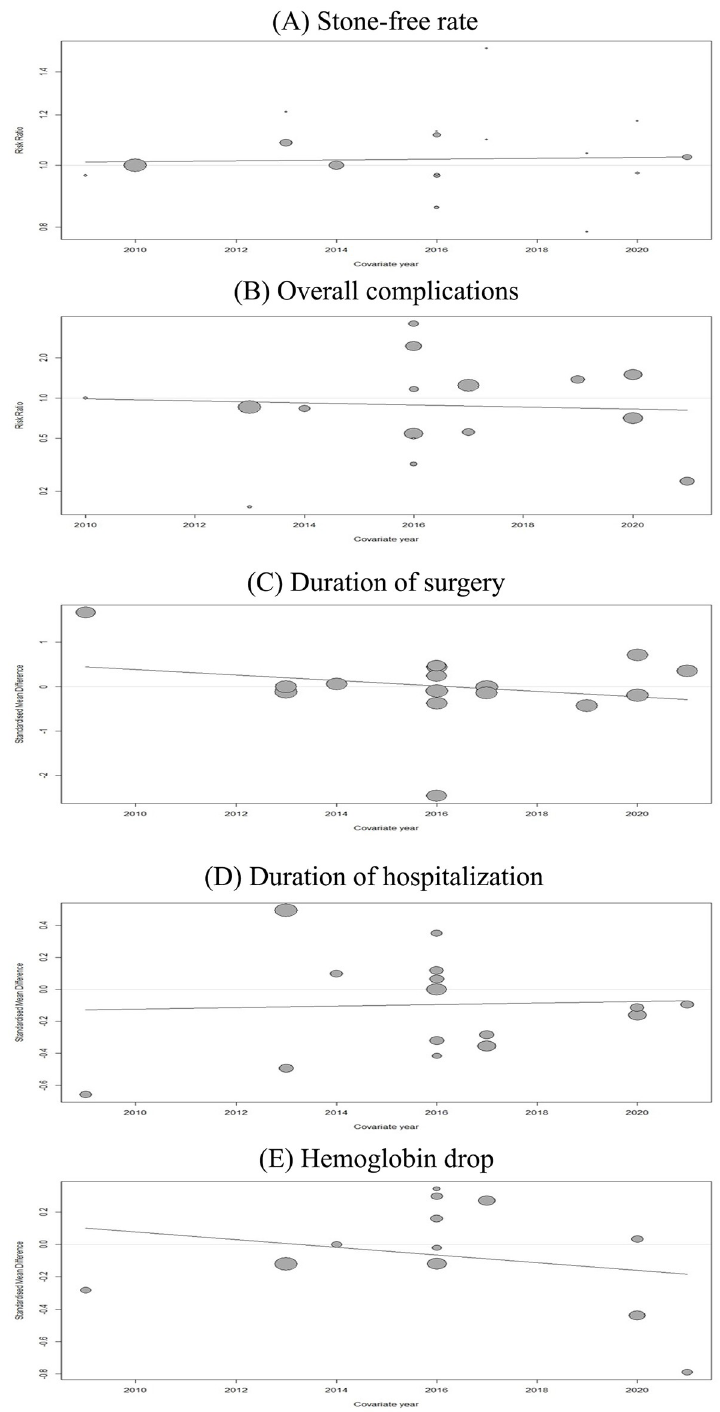
Fig 3. Results of meta-regression. Effects of publication year and the experience of the clinician on primary outcomes.